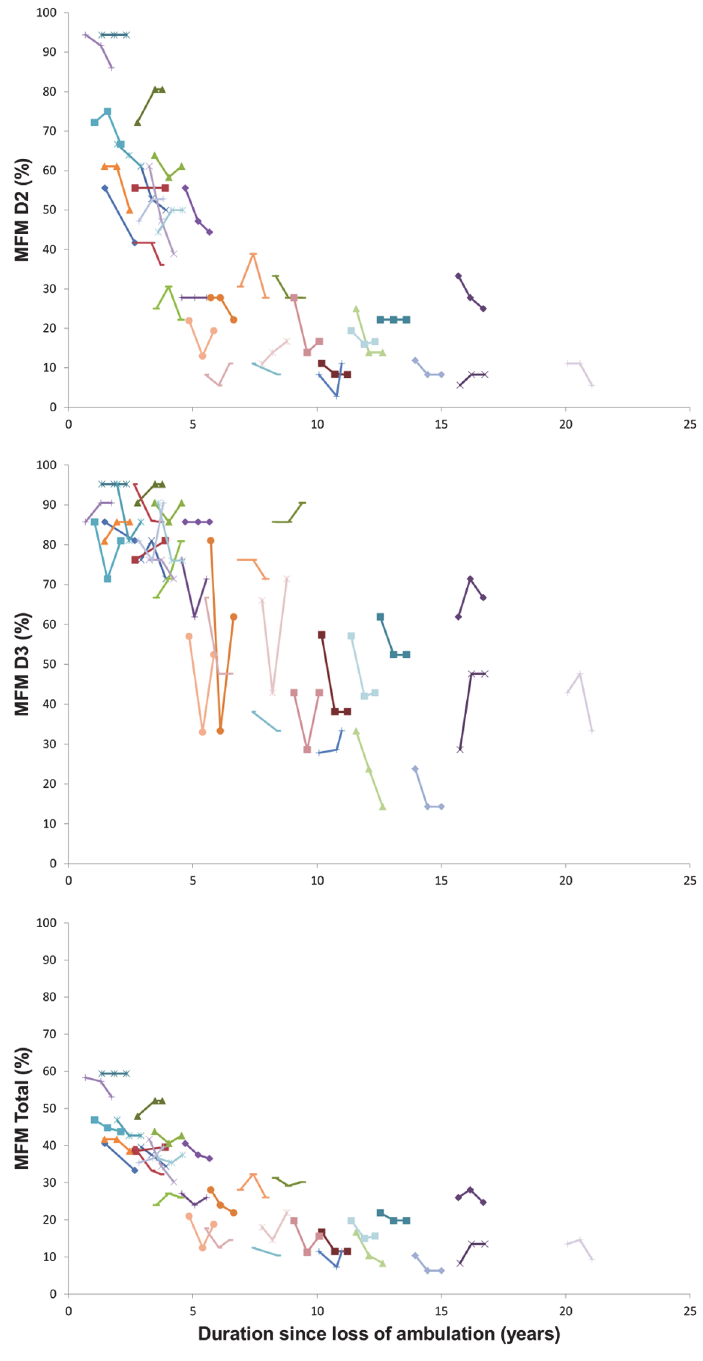
Figure 4. Relation between MFM-D2 and MFM-D3 sub-scores and total score and duration since loss of ambulation at baseline at 6 months and at one year.